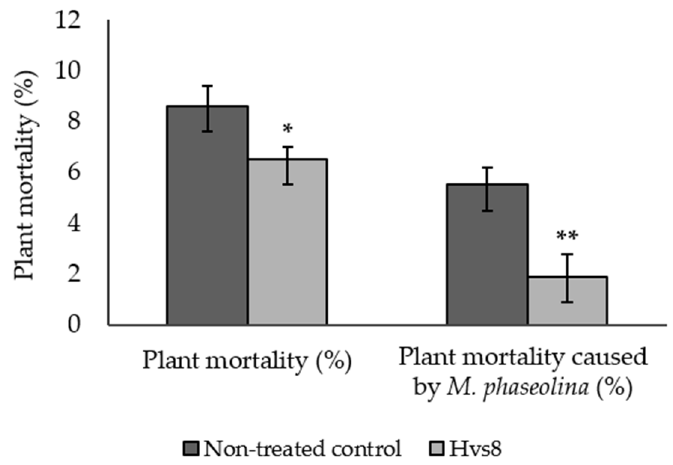
Figure 4. Plant mortality and plant mortality caused by Macrophomina phaseolina ± standard error from Hvs8-treated plants and non-treated control (means of 2018/2019 and 2019/2020 crop seasons). A Wilcoxon Rank Sum Test was used to determine significant differences between the treatments (* p ≤ 0.05; ** p ≤ 0.01). Table 5. Fruit quality parameters of strawberry plants cv. ‘Rociera’ treated with Hvs8 bacterial suspension and non-treated plants (means of 2018/2019 and 2019/2020 crop seasons).